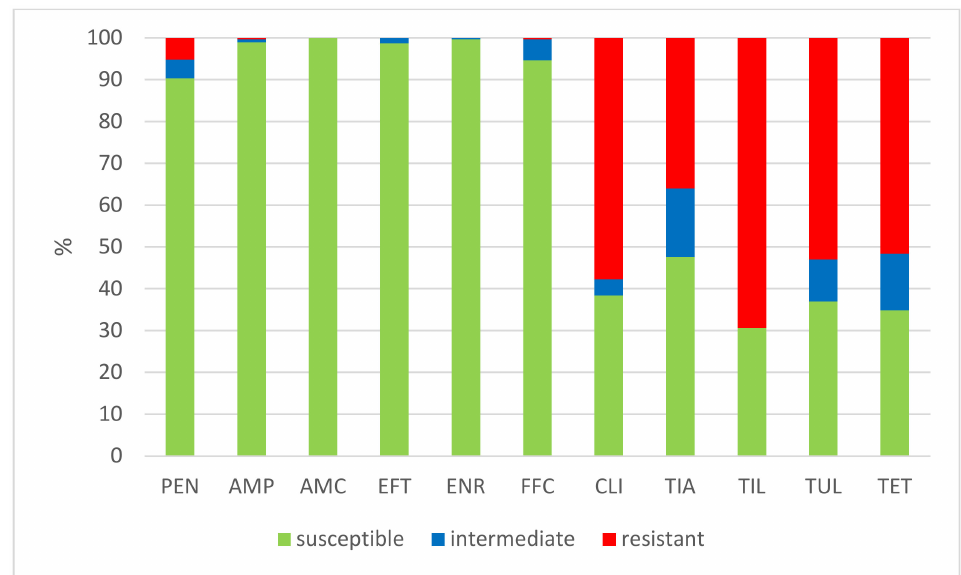
Figure 4. The percentage of susceptible, intermediately resistant, and resistant S. suis isolates from systemic organs in 2018–2022 ( n = 445). PEN = Penicillin; AMP = Ampicillin; AMC = Amoxi- cillin/Clavulanate 2/1; EFT = Ceftiofur; ENR = Enrofloxacin; FFC = Florfenicol; TET = Tetracycline; STX = Trimethoprin/Sulfamethoxazole 1/19; TIA = Tiamulin; TIL = Tilmicosin; TUL = Tulathromycin; CLI =